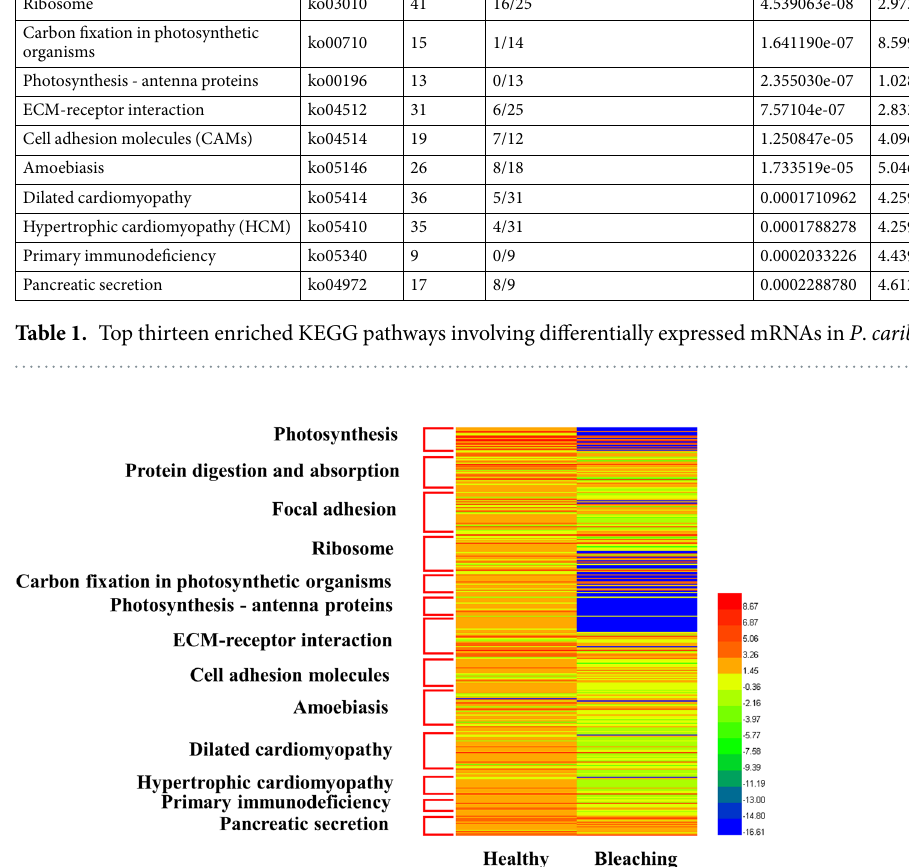
Figure 8. Heatmap of 347 differentially expressed mRNAs enriched to 13 KEGG pathways in P . caribaeorum tissue undergoing bleaching compared to healthy tissue. Expression levels were normalized by logarithmic base